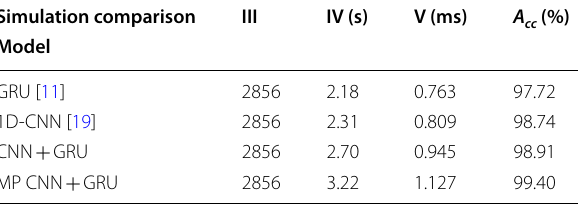
Table 6 Comparison of computation speed on the IEEE 39-bus